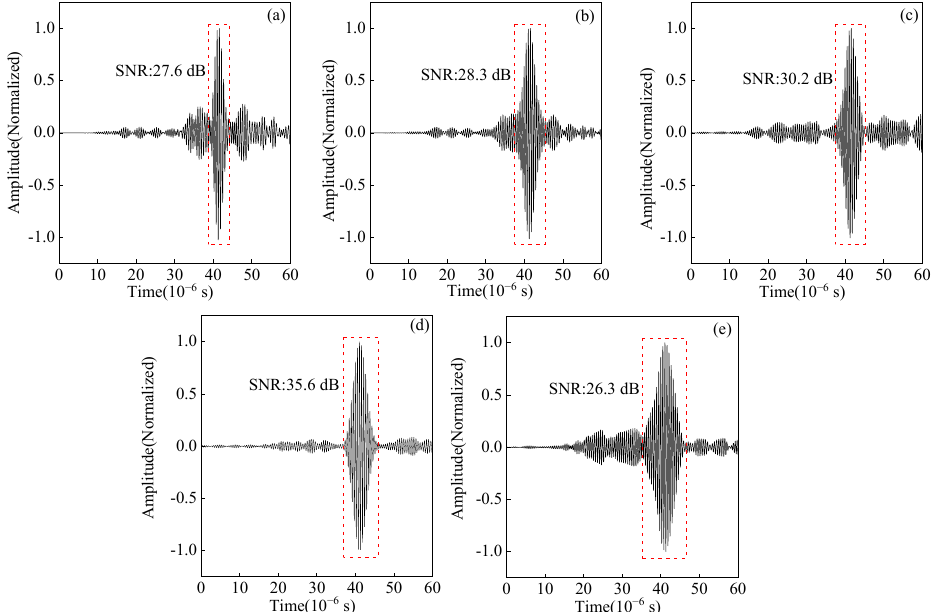
Figure 25. Effect of code element length on the main lobe amplitude of the experimental signal from angled SV wave EMAT after pulse compression ( a ) T = 0.5 μ s ( b ) T = 1 μ s ( c ) T = 1.5 μ s ( d ) T = 2 μ s ( e ) T = 2.5 μ s.